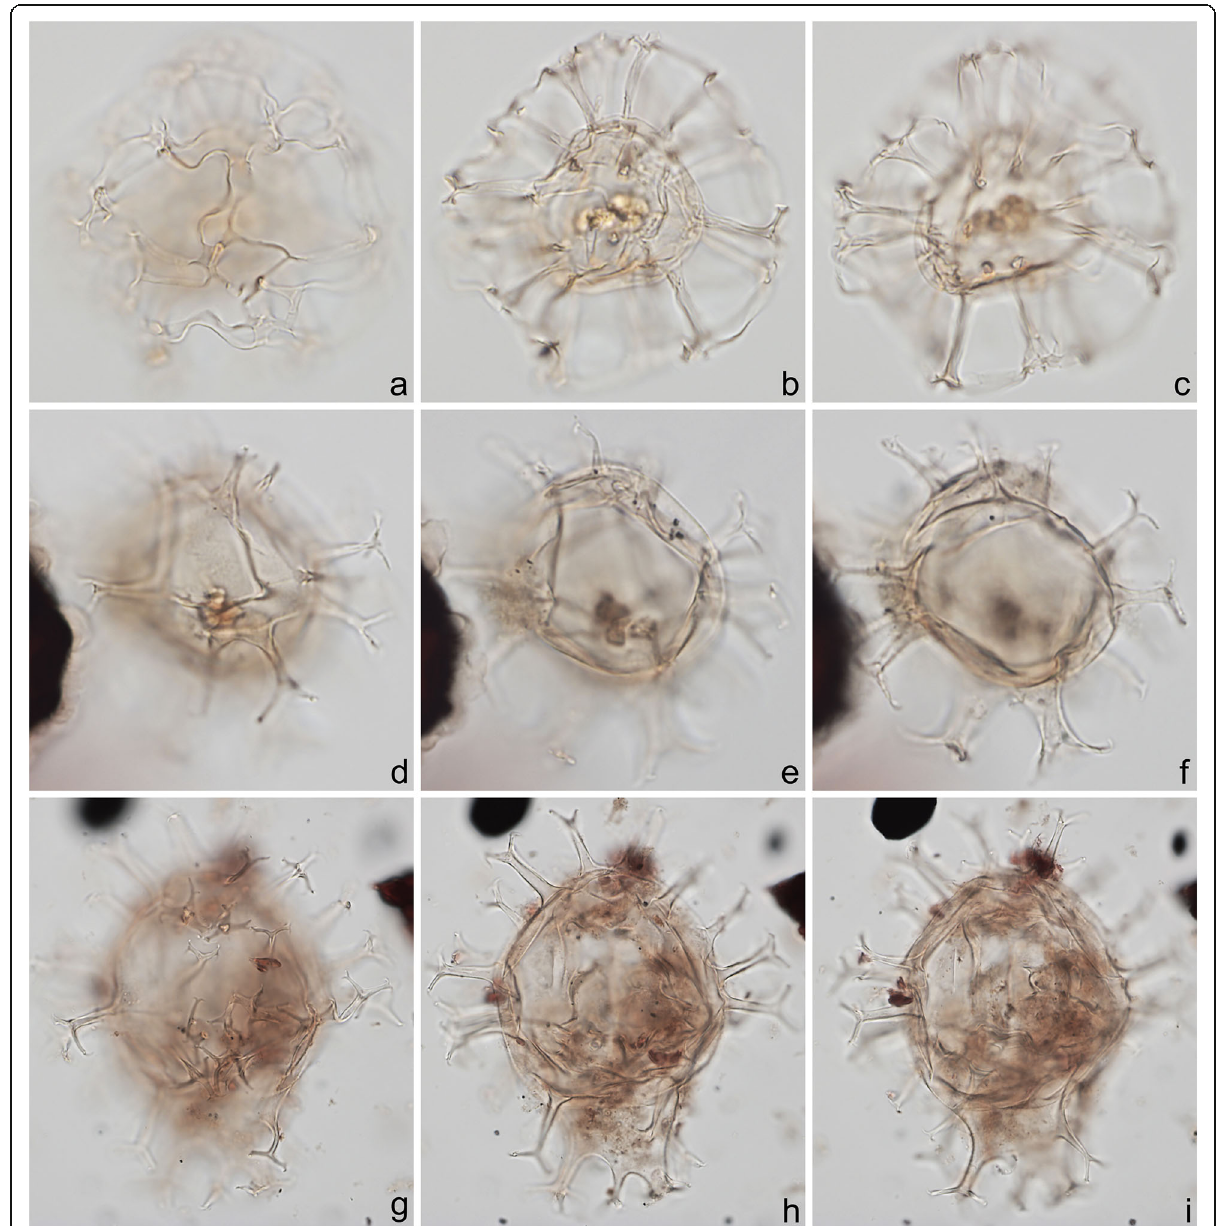
Fig. 5 Dinoflagellate cysts from the Chiba composite section. Max. dia. = maximum diameter. EF = England Finder reference. a – c Nematosphaeropsis labyrinthus , equatorial view at upper, mid-, and lower foci showing nearly smooth central body surface; ectophragm max. dia. 52 μ m, central